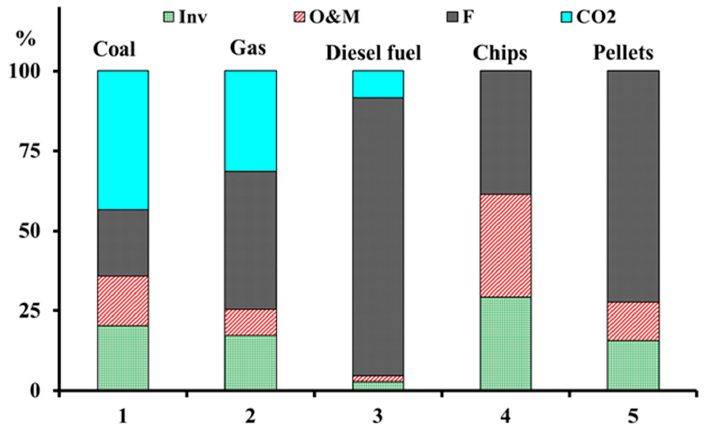
Figure 5. Energy cost components in relative units (Inv is investment, O&M is operation and maintenance, F is fuel, CO 2 associated with the payment for carbon dioxide emissions).